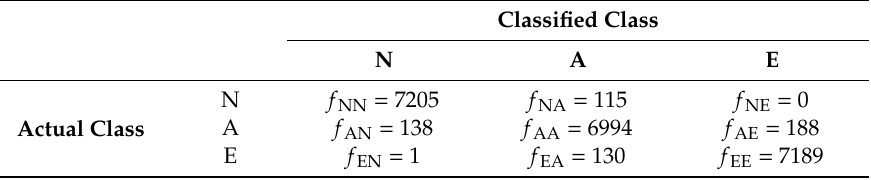
Table 5. Confusion matrix of the